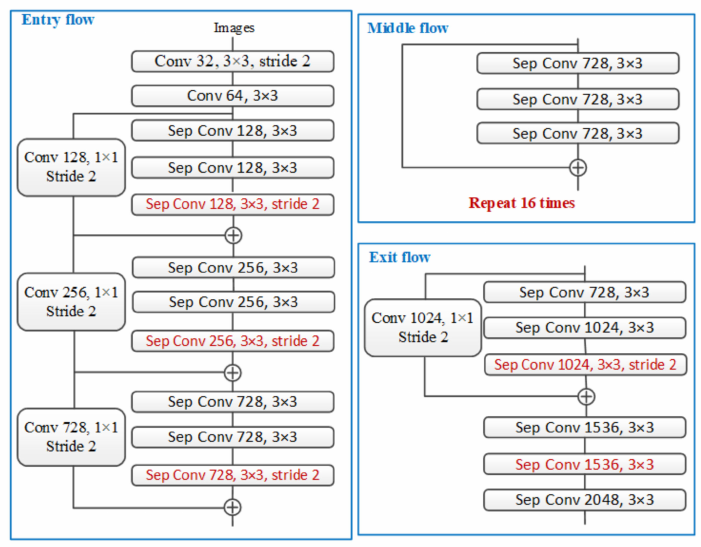
Figure 3. Improved Xception network